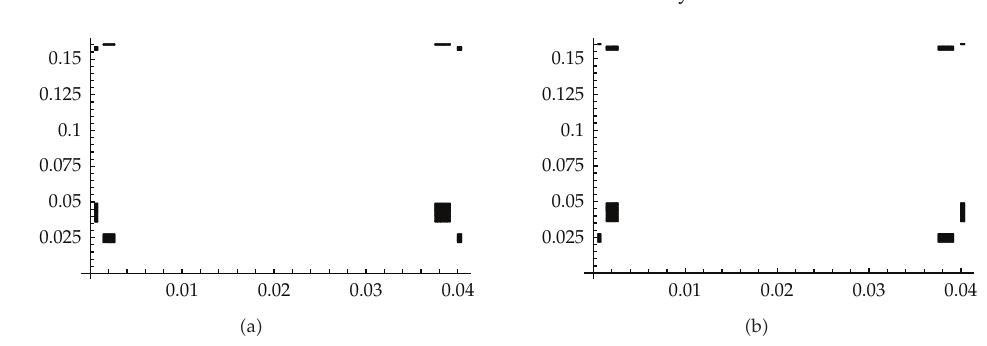
Figure 6: Two di ff erent attractors of type A3 for the parameter value a (cid:6) 6 . 189.